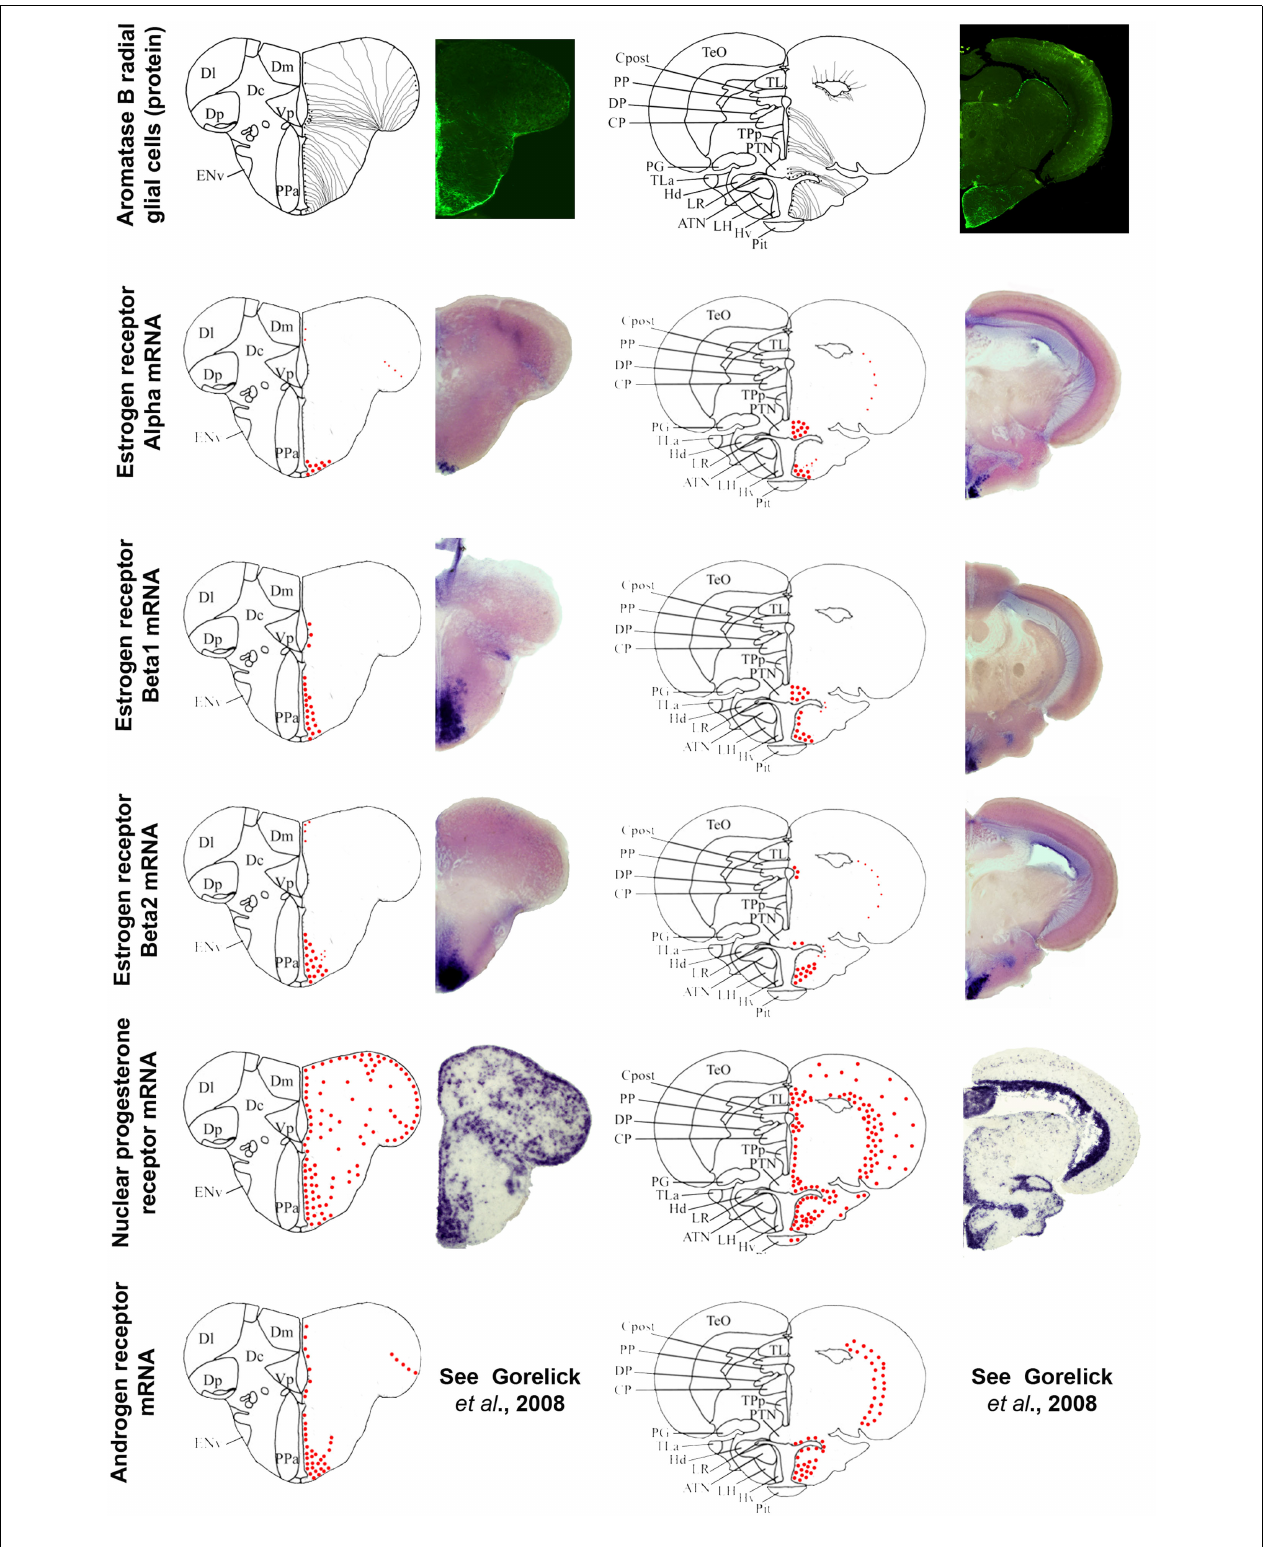
1996). Data on androgen receptors are adapted from Gorelick et al. (2008). Aromatase B-expressing cells are represented in the left panel (according to Menuet et al., 2005) where cell bodies are represented by black dots, while thin lines figure radial